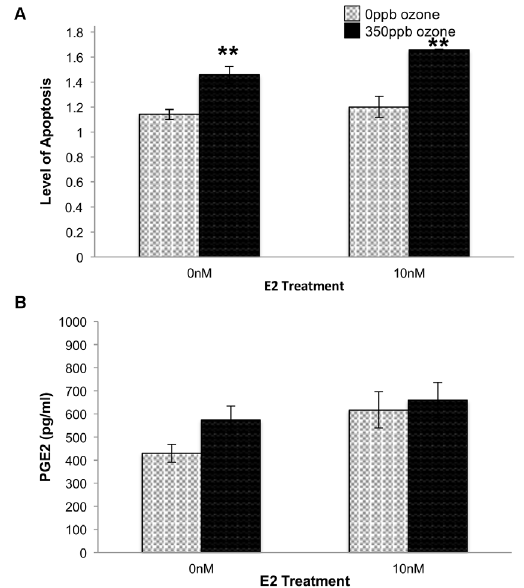
Figure 3. Effect of E2 and O 3 on relative levels of apoptosis (A) and PGE2 secretion (B) 24 hr after gas exposure. 10 4 L2 cells/well were treated with E2 and 350 ppb O 3 as indicated. After 24 hr, levels of apoptosis (F=12.0440, df=3,13, p=0.0012) were determined and media samples were collected from a separate set of cells to determine PGE2 secretion (F=2.3803, df=3,11, p=0.1453). Values of apoptosis represent the mean of 3–4 replicates normalized to data from control cells (-E2, in non-flowing 5% CO 2 /air), 6 S.E.M. ** p # 0.01 compared to 0 ppb O 3 .